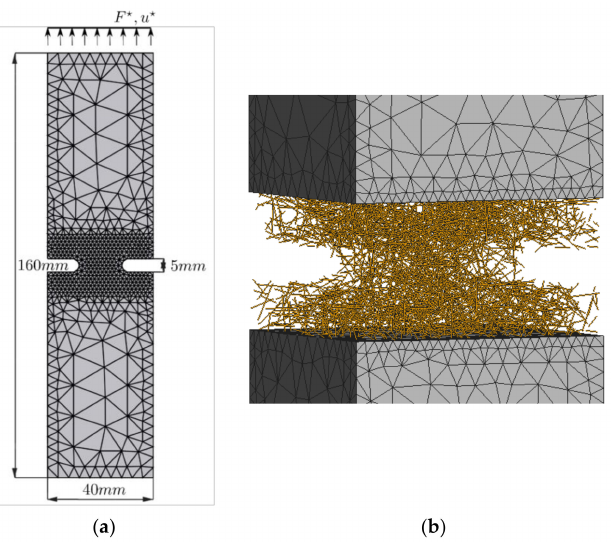
Figure 8. ( a ) The front view showing the dimensions of the notched prism model. Dimensions not shown in the figure: The depth of the notch is 10 mm, and the thickness of the specimen is 40 mm. Boundary conditions: motion of the bottom surface is precluded in all three spatial directions, the horizontal motion of the top surface is precluded, and the vertical displacement ( u ∗ ) of the top surface is prescribed according to the experimental program. ( b ) The side view of randomly distributed and oriented fibers in the central part of the notched prism specimen (solid and interface elements